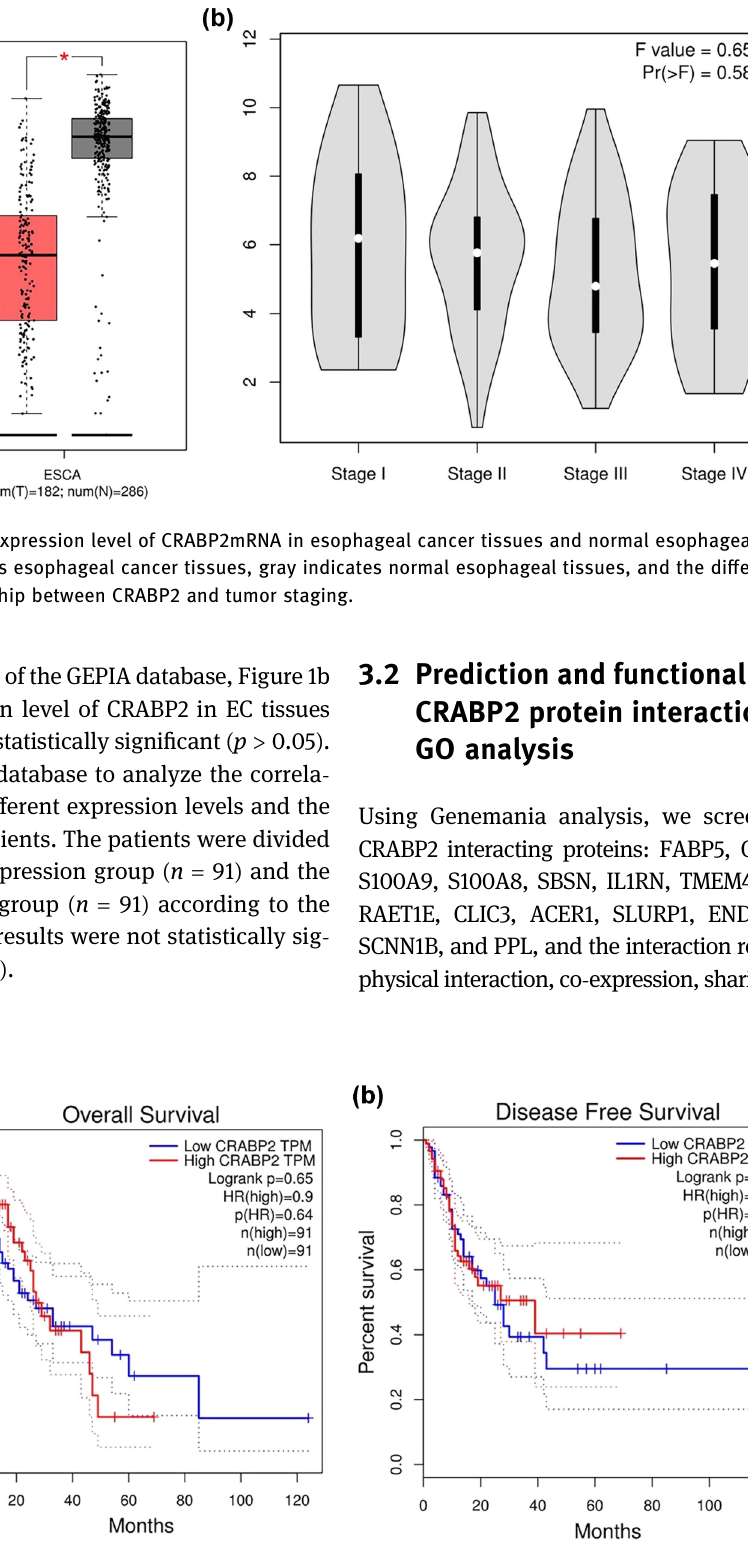
Figure 2: ( a ) Analysis ofthe overall survival ofpatients with esophageal cancer withdi ff erent expression levels of CRABP2 in the GEO database. ( b ) Analysis of the disease free survival of patients with esophageal cancer with di ff erent expression levels of CRABP2 in the GEO